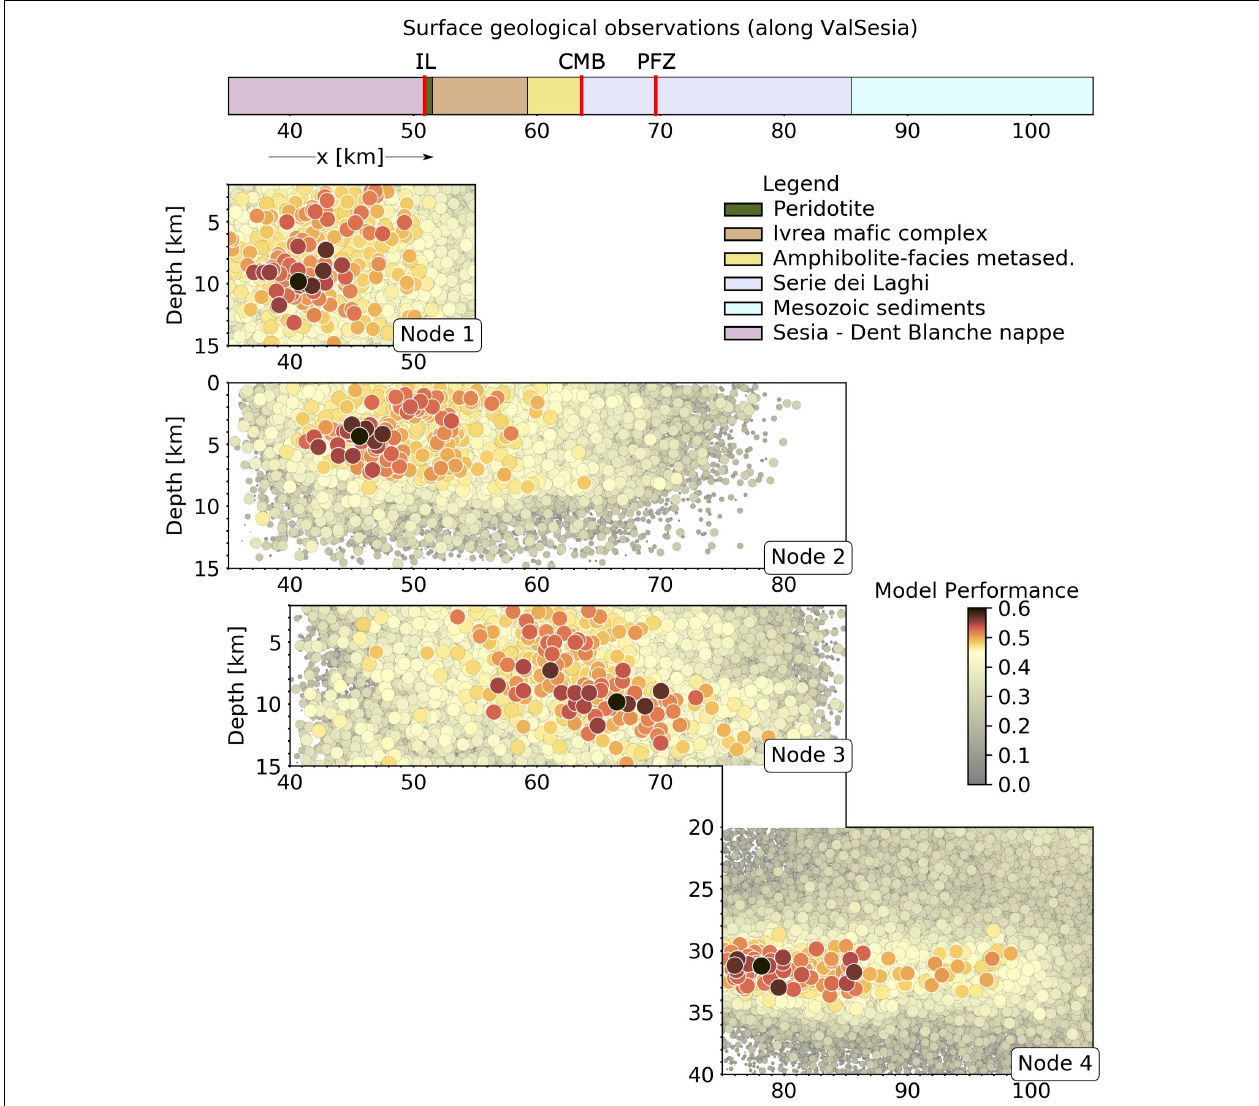
FIGURE 8 | Inversion results on the position of the four nodes, presented in four distance–depth panels. Each panel is showing the locations visited by each single node during the inversion, for each sampled model. All four panels share the same horizontal X -axis, but they are shifted along the vertical direction for better visual distinction. Panels of nodes 3 and 4 share the same depth axis, too. All sampled and kept models are shown (in total 41’363), with size and color according to the model performance, plus all models with performance higher than 0.48 are indicated by white edges. Each panel is limited to the allowed range of parameter values. On top, the corresponding surface geological observations from earlier studies (along the same X -axis), identifying rock types along the profile (legend on the top right, same as in Figure 2 ). The relevant faults for this study are indicated (as in Figure 2 ) as “IL” for Insubric Line, “CMB” for Cossato-Mergozzo-Brissago Line and “PFZ” for Pogallo Fault